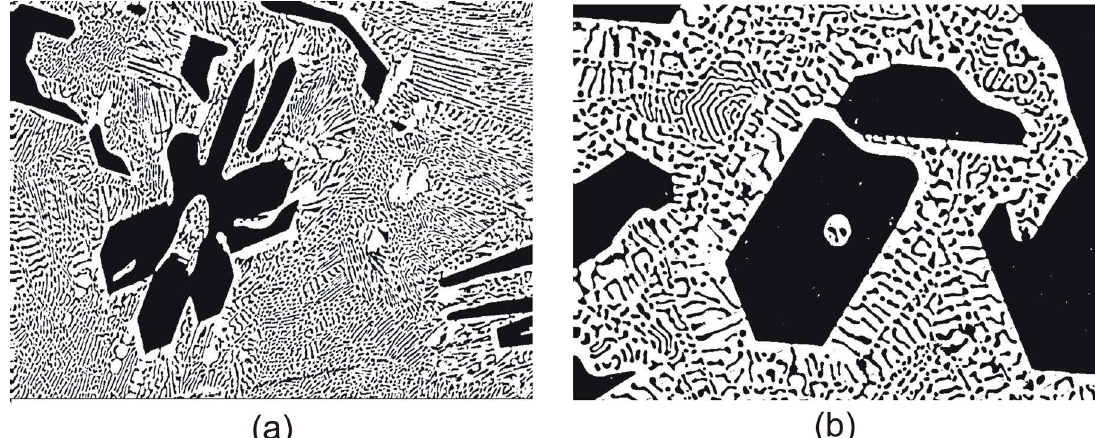
Figure 12. Binary images (using the ImageJ® software): (a) sample P_10mm IMCs = 39% and (b) sample P_70mm IMCs =